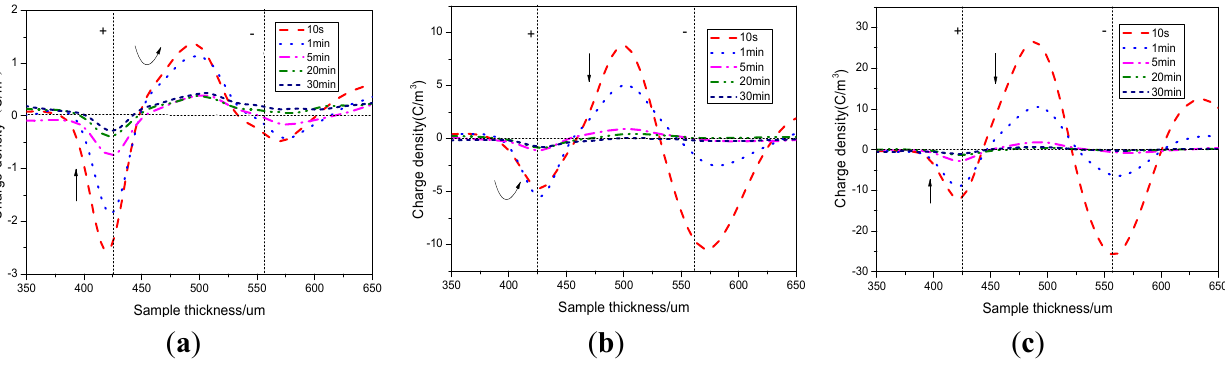
Figure 6. Volt-off space charge distribution of paper samples: ( a ) without contamination; ( b ) with contamination; and ( c ) with more contamination.